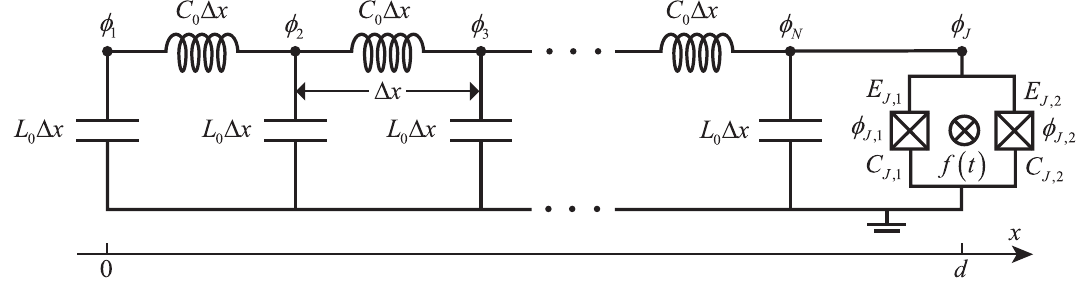
Figure A4: Equivalent circuits for an superconducting transmission line (STL) terminated by a superconducting quantum interference device (SQUID).Weassumethattheleftend,at x =0,oftheSTLisopen,anditsrightend,at x = d ,isconnectedtotheSQUID.TheSTLoflength d hasa characteristiccapacitance C 0 andinductance L 0 perunitlength.TheSTLismodeledasaseriesof LC circuitseachwithacapacitance C 0 Δ x and a inductance L 0 Δ x . Here, Δ x is a small distance. We assume ϕ ( i = 1, 2, 3, … , N ) to be the node phases between these LC circuits. The SQUID i consists of two Josephson junctions, and we use E J , i , C J , i , and ϕ J , i ( i = 1, 2) to label the Josephson energy, capacitance, and phase of the i th junction, respectively. The phases ϕ J , i are determined by a driving phase f ( t ) across the SQUID, such that f ( t ) (cid:2) ( ϕ (cid:2) ( ϕ + ϕ ) / 2. In the continuum limit N → ∞ , we have Δ x → dx and ϕ phase ϕ J of the SQUID is given by ϕ J J , 1 J , 2